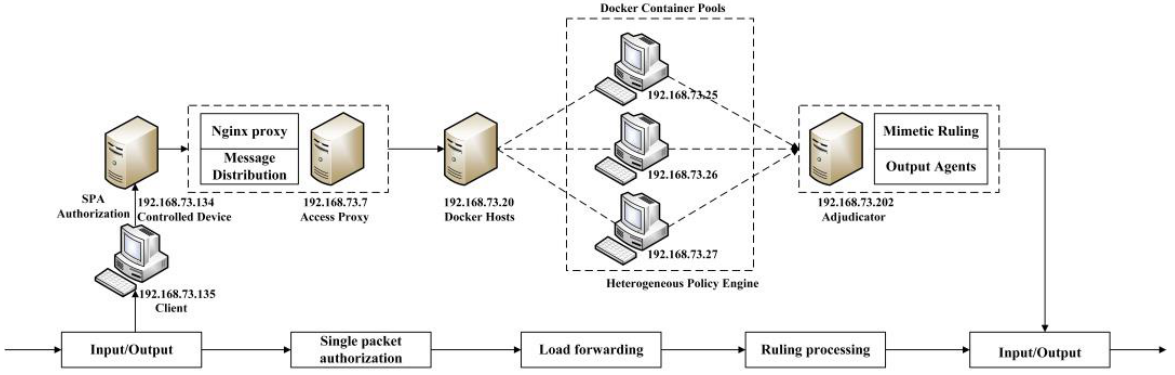
Figure 9. System topology.